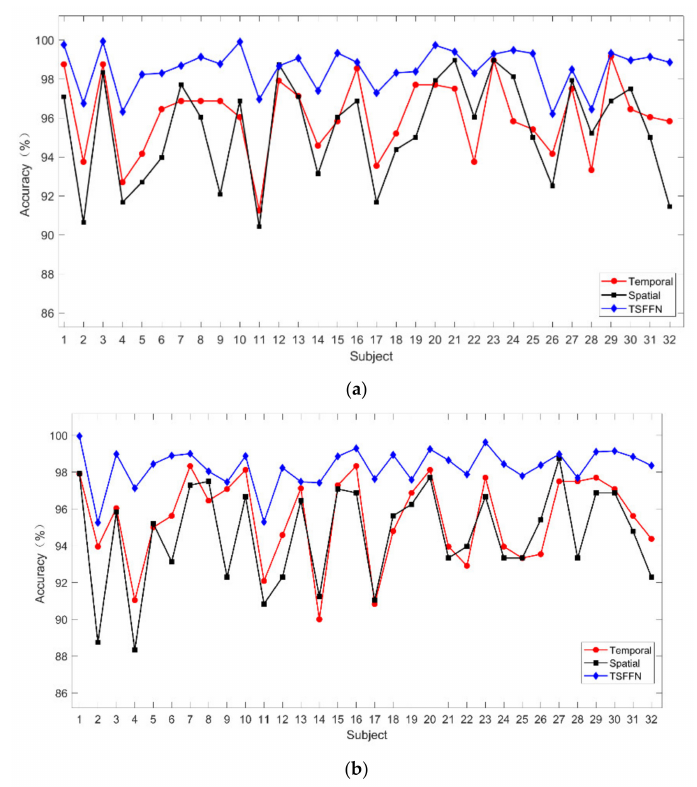
Figure 10. The results of ablation experiments on Arousal ( a ) and Valence ( b